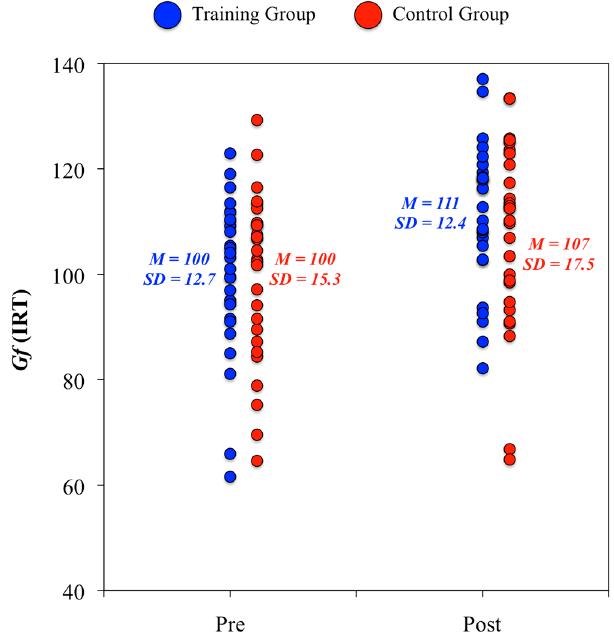
Figure 3. Individual score changes in fluid ability from the pretest to the posttest psychological evaluation.